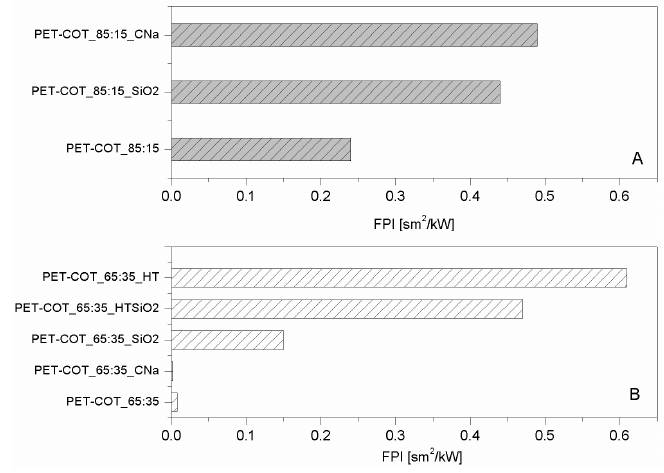
Figure 6. FPI values of NP-treated PET-COT_85:15 ( A ) and NP-treated PET-COT_65:35 fabrics ( B ). Data obtained by cone calorimetry at 35 kW/m 2 .